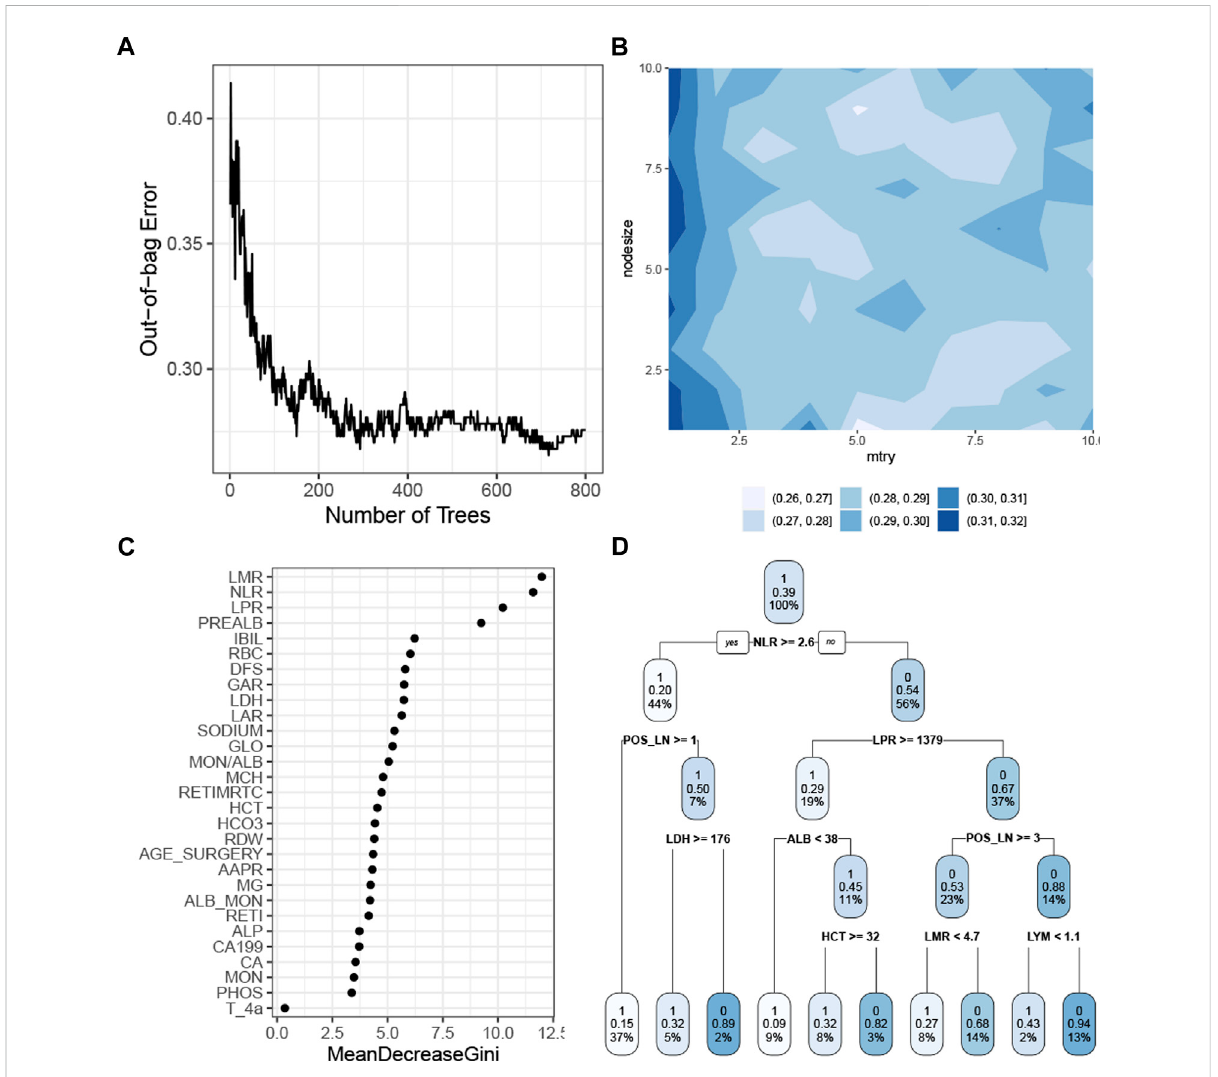
FIGURE 4 Construction of theRF model. (A) Correlation ofthe out-of-bag error with the number of trees. (B) Simulation testof tuning mtry and nodesize measured by the AUROC. (C) Feature importance as measured by the RF algorithm. (D) Global surrogate model visualized by a decision tree to approximate the predicted response by the RF model. Abbreviations: RF, random forest; AUROC curve, area under the receiver operating characteristic curve; LMR, lymphocyte – monocyte ratio; NLR, neutrophil – lymphocyte ratio; PREALB, prealbumin; IBIL, indirect bilirubin; RBC, red blood cell; DFS, disease-free survival; GAR, γ -glutamyl transpeptadase – albumin ratio; LDH, lactic dehydrogenase; LAR, lymphocyte – albumin ratio; GLO, globulin; MON, monocyte; ALB, albumin; MCH, mean corpuscular hemoglobin; RETIMRTC, moderate fl uorescence – reticulocyte ratio; HCT, hematocrit; RDW, red cell distribution width; AAPR, albumin-to-alkaline phosphatase ratio; RETI, reticulocyte count; ALP, alkaline phosphatase; PHOS,